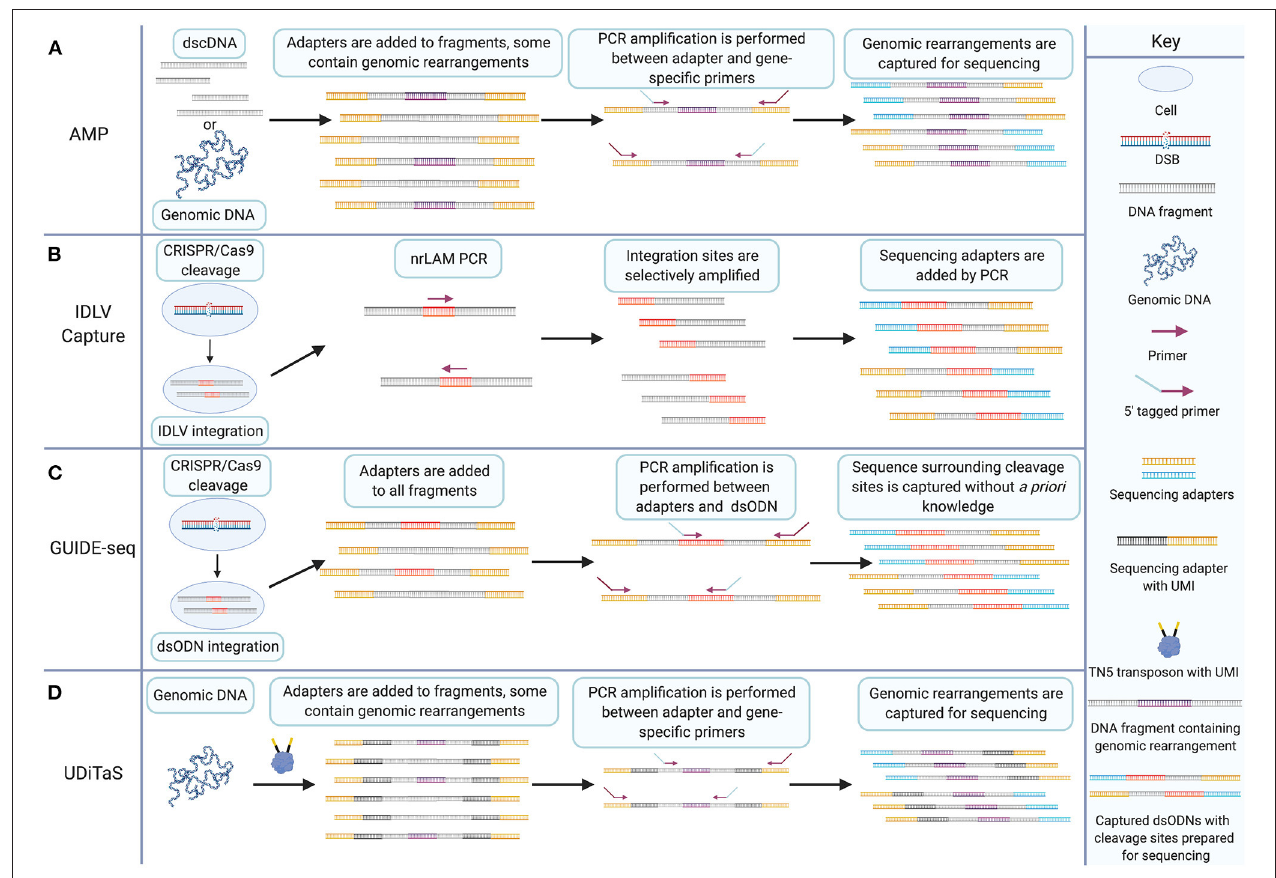
FIGURE 3 | The GUIDE-seq target enrichment strategy combines IDLV capture and AMP for CRISPR/Cas9 cleavage detection without a priori knowledge. (A) AMP involves adding half-functional adapters (shown in yellow) to both ends of double-stranded cDNA or sheared genomic DNA. Fragments may contain genomic rearrangements that are amplified by PCR between a single anchored gene-specific primer site and a half-functional adapter. 5 ′ tags on primers enable addition of a second sequencing adapter to amplified target sites. Non-target sites do not get the additional adapter and are excluded from sequencing. (B) IDLV capture involves transfection of CRISPR/Cas9 and transduction of IDLV which is integrated into CRISPR/Cas9-induced DSBs during NHEJ, shown in red. nrLAM PCR selectively amplifies cleavage sites from the integrated sequence. Additional rounds of PCR add sequencing adapters (shown in blue and yellow) to the amplicons. (C) GUIDE-seq involves transfection of CRISPR/Cas9 and dsODN linkers (shown in red) that are incorporated into cleavage sites during NHEJ. Genomic DNA is fragmented, and half-functional universal adapters (shown in yellow) are added to all fragments. PCR amplification between dsODN and half-functional universal adapters using 5 ′ tagged primers enables selective amplification of sequence surrounding cleavage sites and the addition of a second adapter necessary for sequencing. (D) UDiTaS involves tagmentation of genomic DNA from nuclease-edited cells. Tagmentation fragments DNA and introduces unique molecular indices (UMIs) and adapters. Target enrichment is achieved by selective amplification of fragments between adapters and gene-specific sites. Genomic rearrangements can then be sequence using next-generation sequencing platforms. Created with